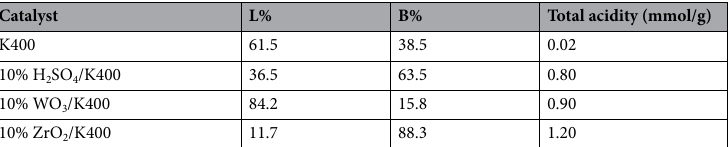
Table 2. Distribution of Lewis (L) and Brønsted acid (B) sites and the total acidity on K400, 10% H 2 SO 4 /K400, 10% WO 3 /K400, and 10% ZrO 2 /K400 catalysts calcined at 400